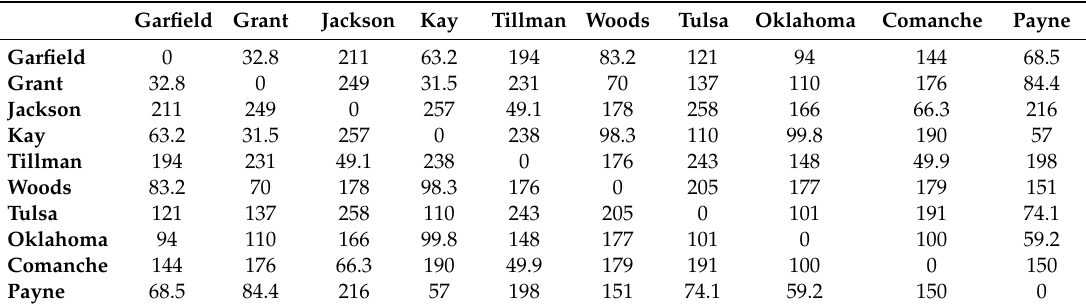
Table A1. Road distances between all locations, Oklahoma case.